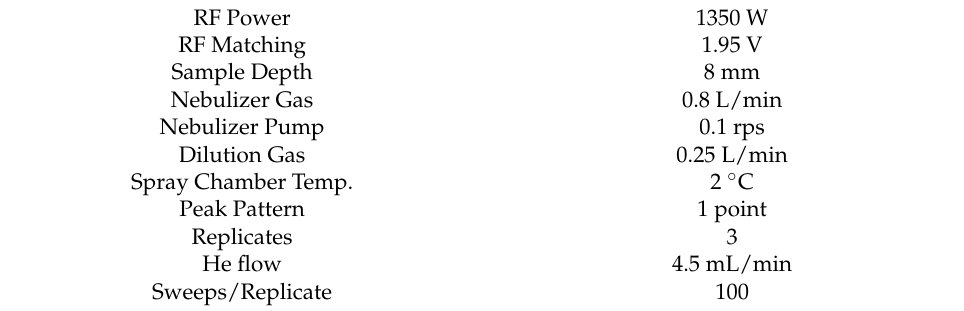
Table 2. ICP-MS operating